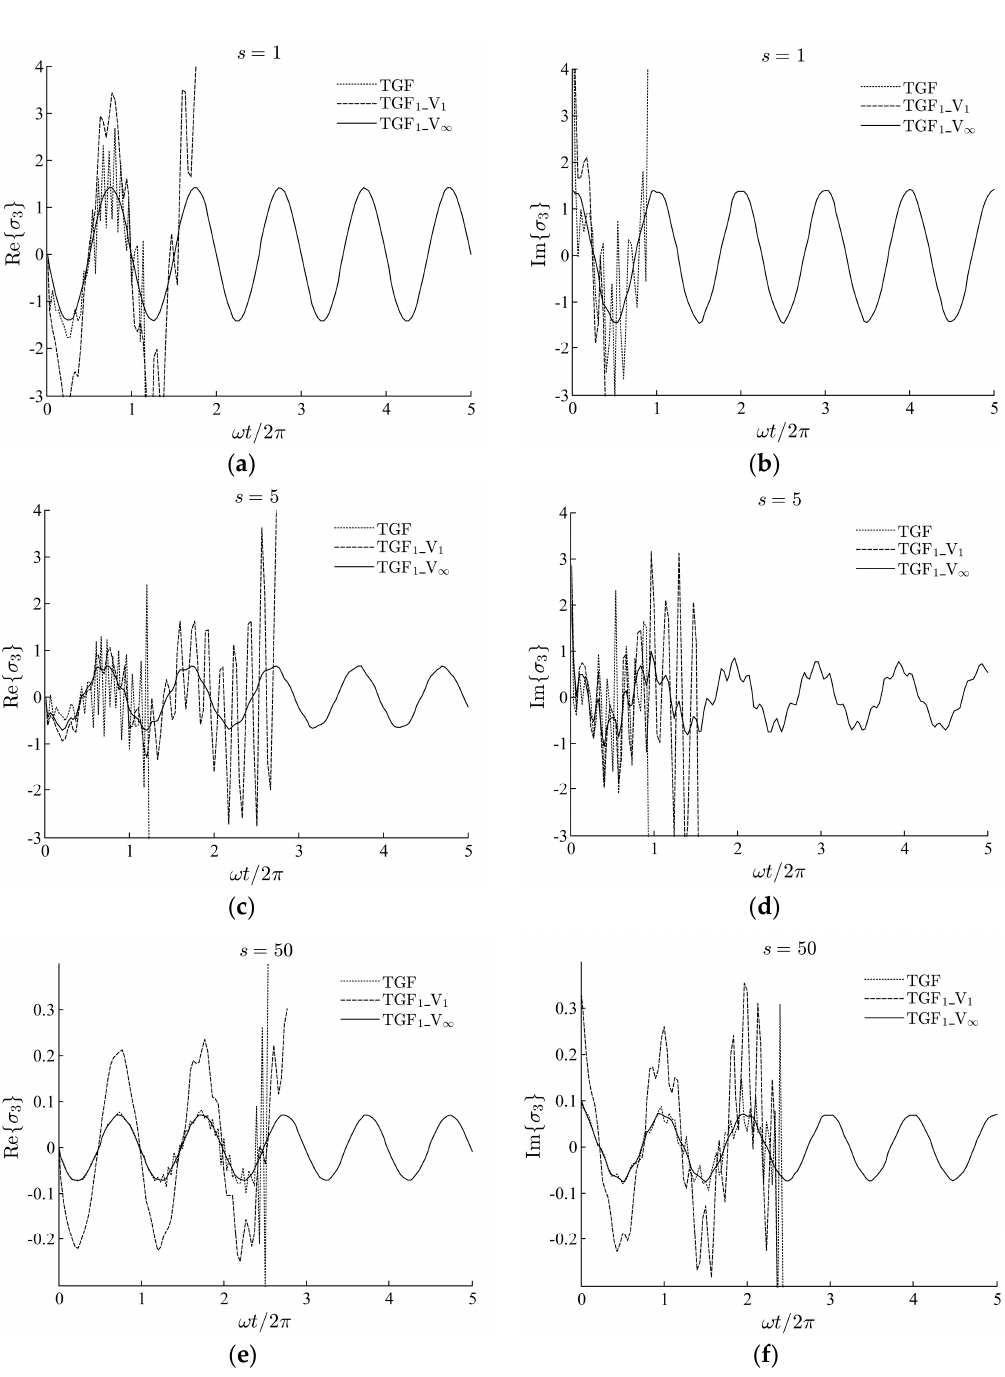
Figure 1. A wedge harmonically heaves on the water surface, with mean draught (cid:1856) = 1 m , half of mean breadth (cid:1854) = 1 m , flare angle (cid:2016) = 45 (cid:2925) , and heave frequency (cid:2033) = 0.8 rad/s . Each side of the wetted surface of the wedge are equally divided into 50 segments.